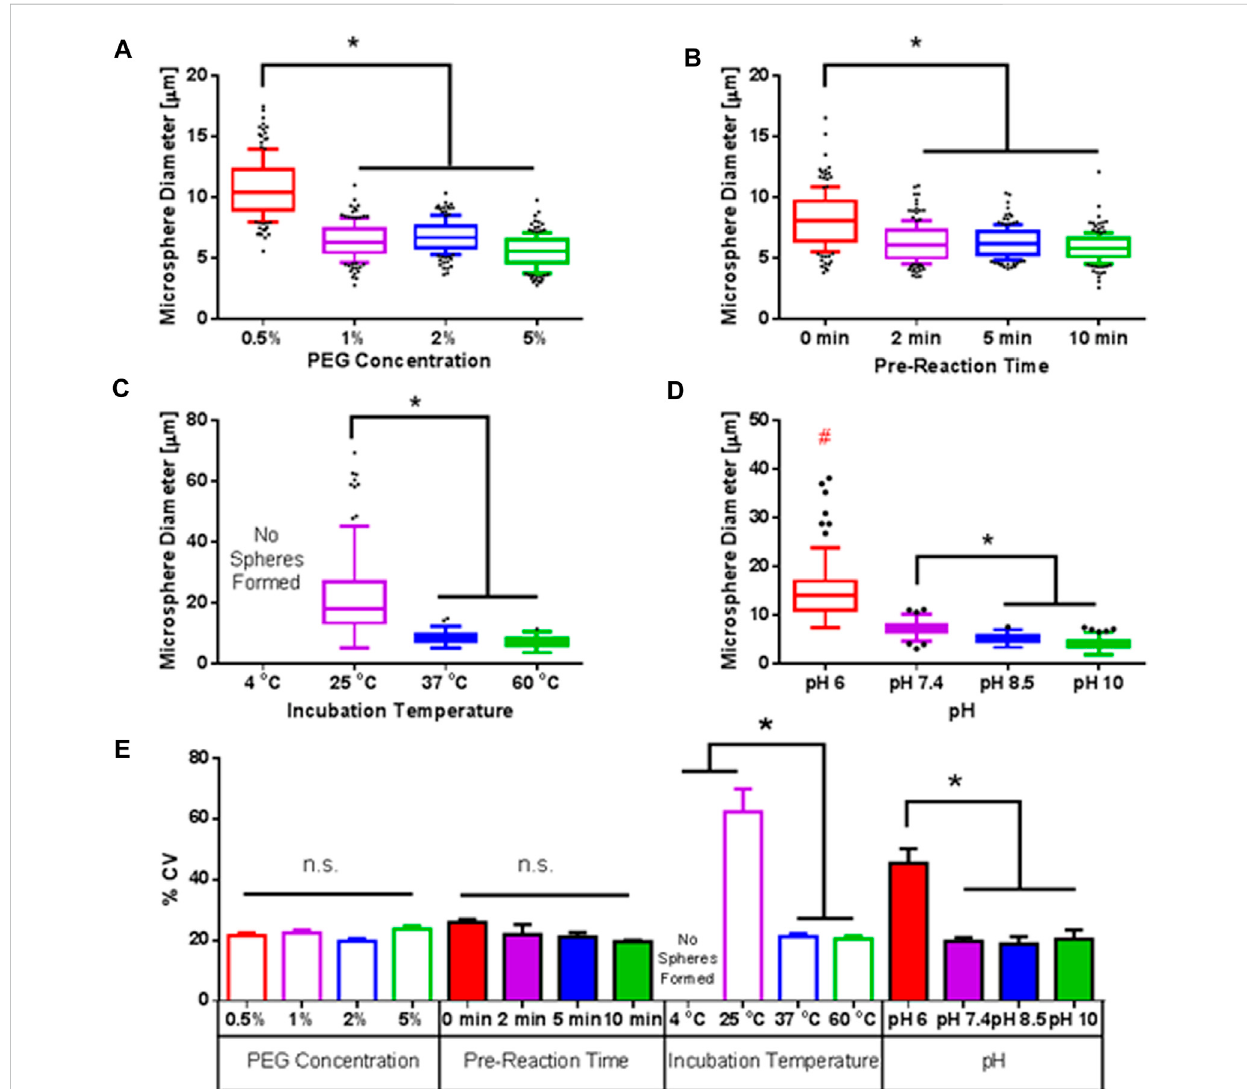
FIGURE 2 Parametric Optimization of Fabrication Conditions. Effect of pH (A) , pre-reaction time (B) , incubation temperature (C) , and pH (D) on microsphere diameter and polydispersity. For each condition, we used 2% w/v PEG, 5 min pre-reaction time, 37 ° C, and pH 7.4, unless noted otherwise. Data represents > 200 microspheres for each condition. (E) Calculated % coef fi cient of variance (% CV) for each measured group. * indicates statistically signi fi cant difference ( n = 3, p <